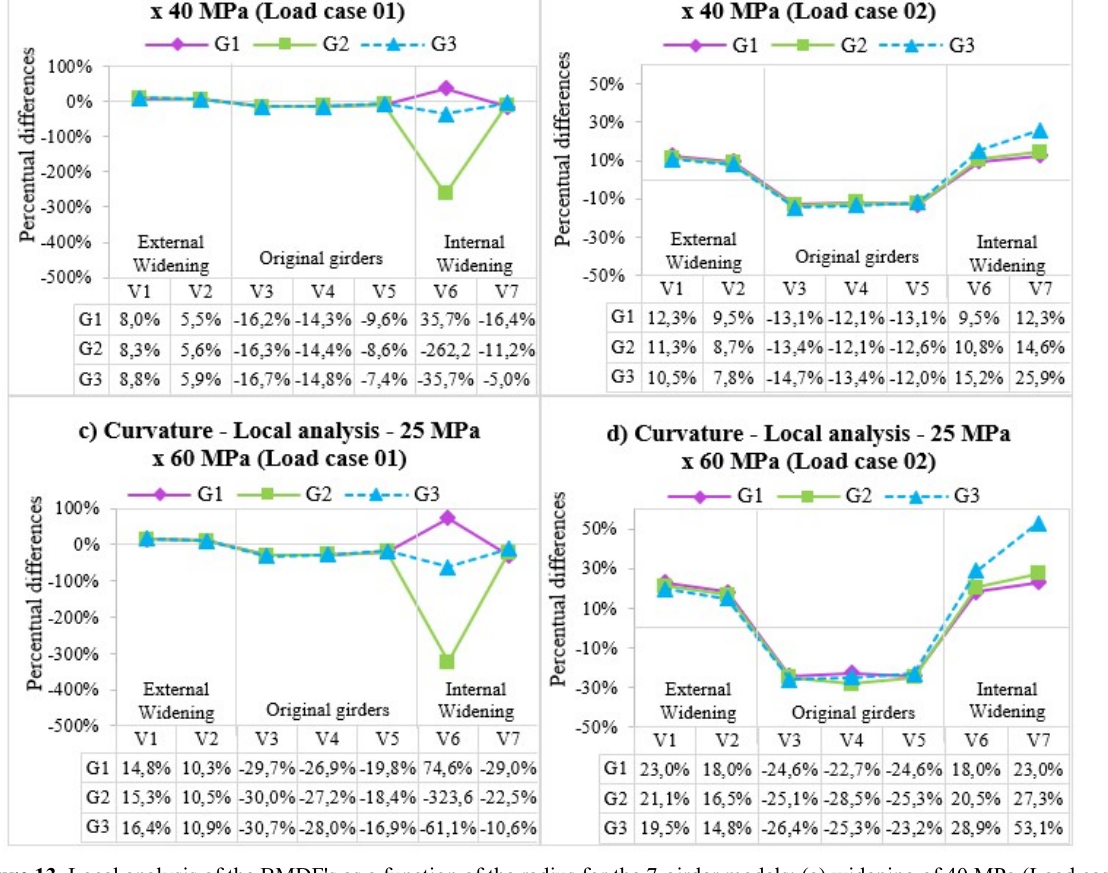
Figure 13. Local analysis of the BMDF's as a function of the radius for the 7-girder models: (a) widening of 40 MPa (Load case 01); (b) widening of 40 MPa (Load case 02); (c) widening of 60 MPa (Load case 01); (d) widening of 60 MPa (Load case